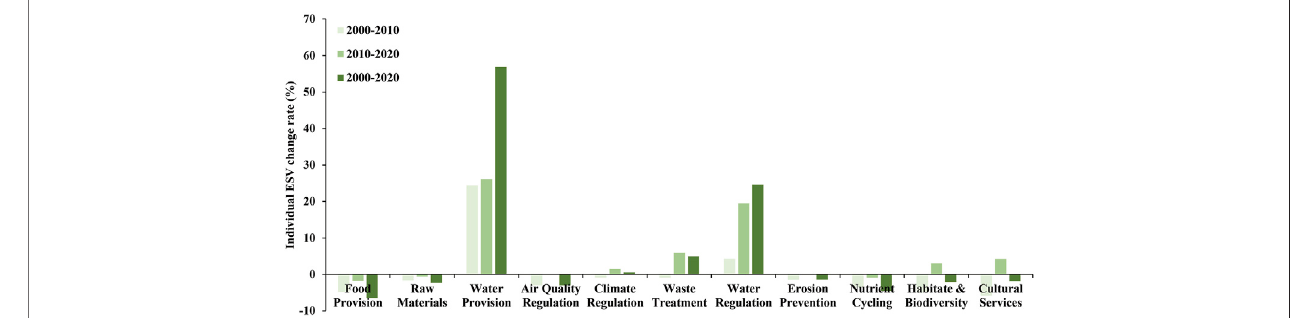
FIGURE 5 | Temporal changes in individual ecosystem service values in the Beijing-Tianjin-Hebei region.